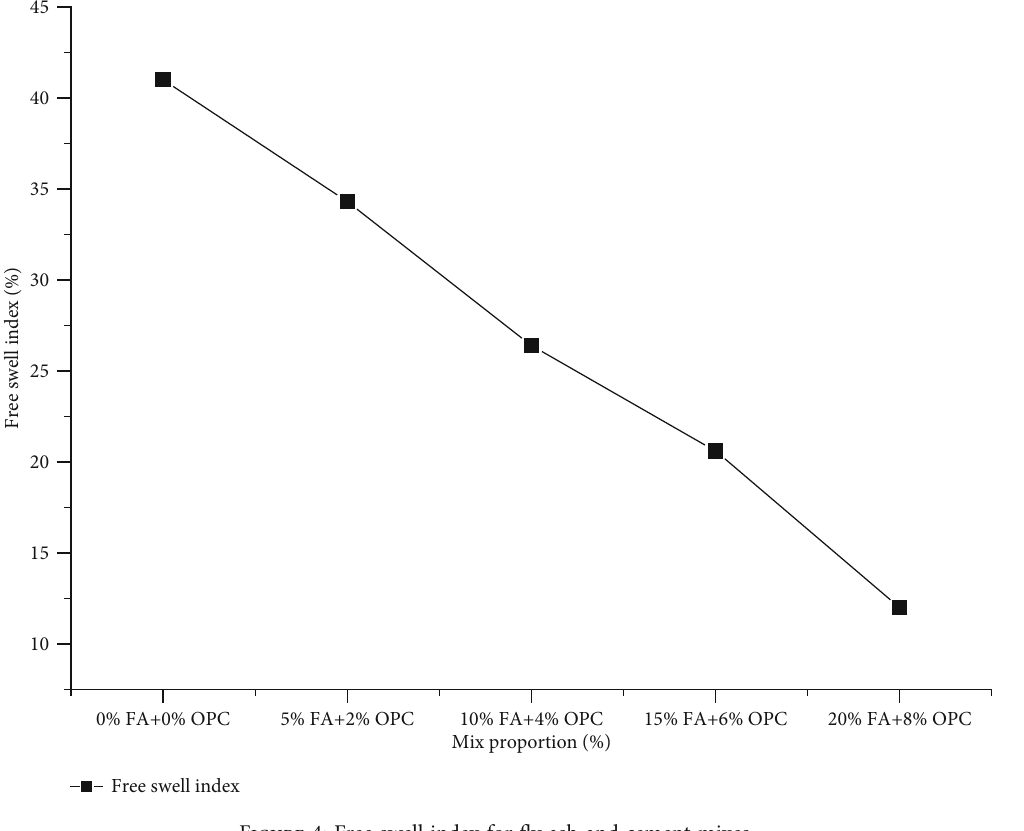
Figure 4: Free swell index for fl y ash and cement mixes. Table 5: The compaction test